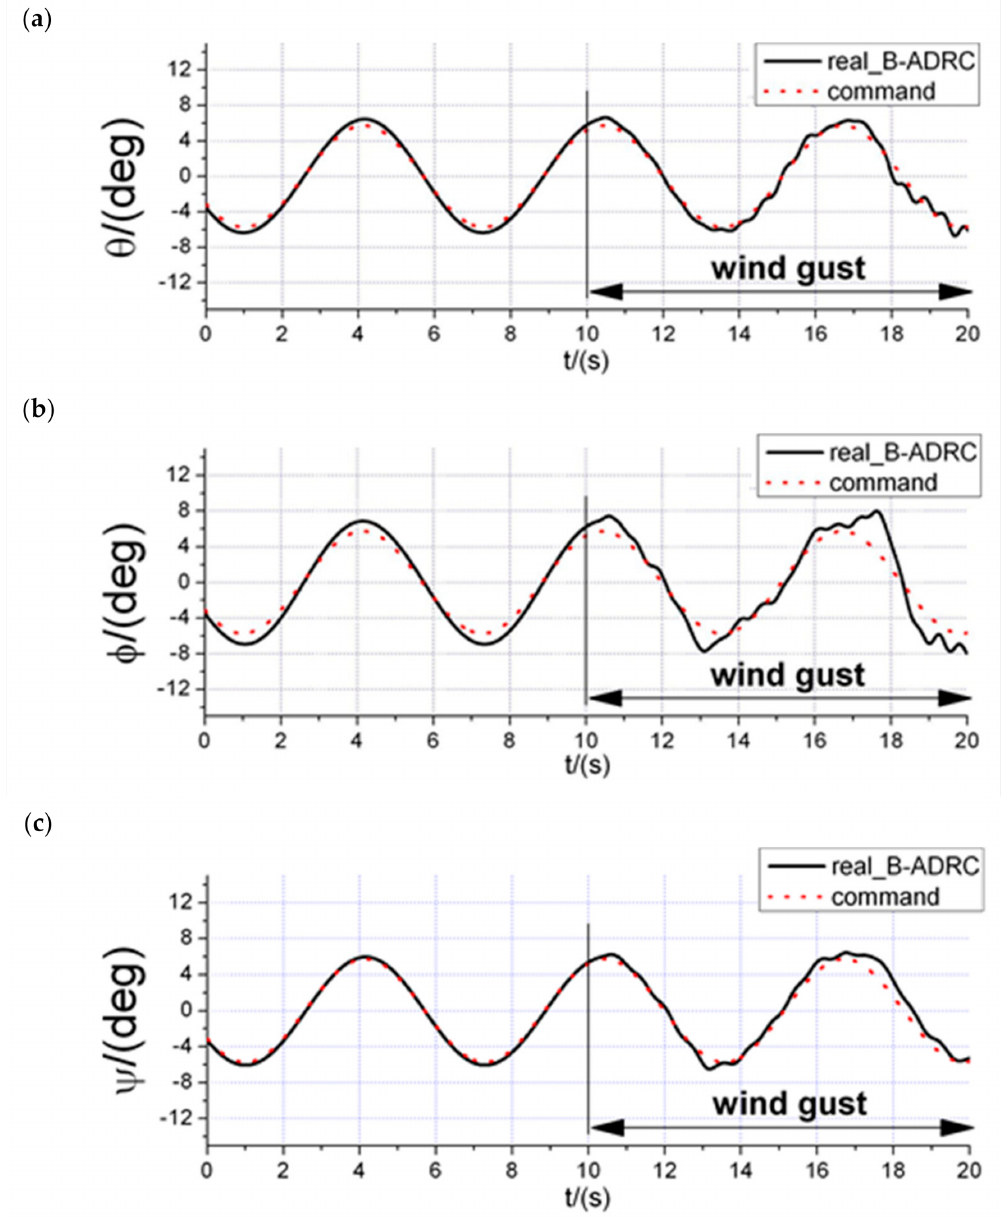
Figure 5. Attitude tracking with model uncertainty. ( a ) Tracking of pitch angle; ( b ) tracking of roll angle; ( c ) tracking of yaw